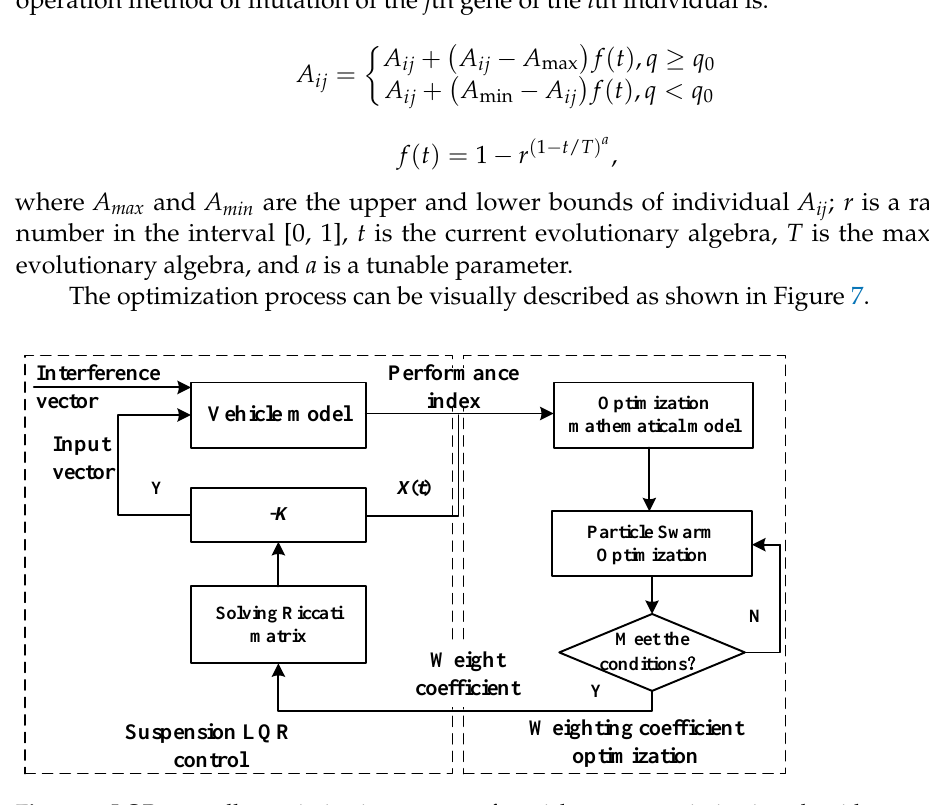
Figure 7. LQR controller optimization process of particle swarm optimization algorithm.